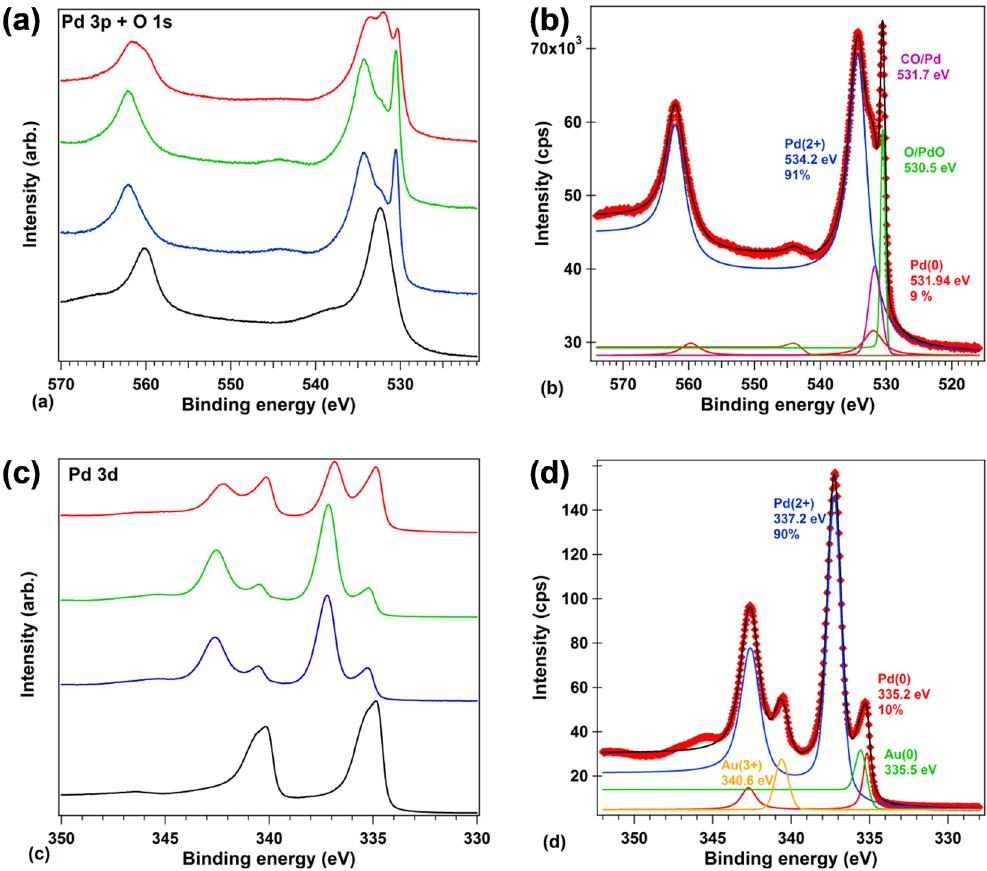
Figure 4. XPS spectra of ( a , b ) Pd 3p and O 1 s, ( c , d ) Pd 3d recorded on PdO/Pd/Au/Ti/SiO2/Si electrodes after (black) EC deposition, (blue) thermal, (green) basic and (red) acid treatment. ( b , d ) Deconvolution of the signals on the spectra recorded after thermal